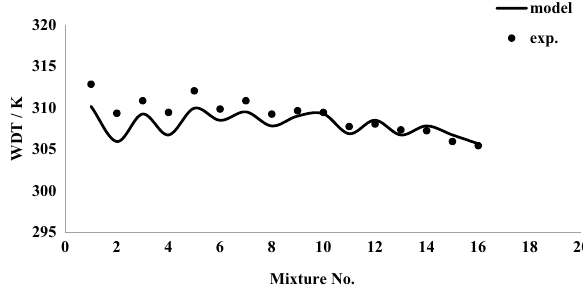
Mixture No. Fig. 6 Comparison of experimental (Metivaud et al. 1999) and pre- dicted WDT vs. mixture number for system #3 exp.